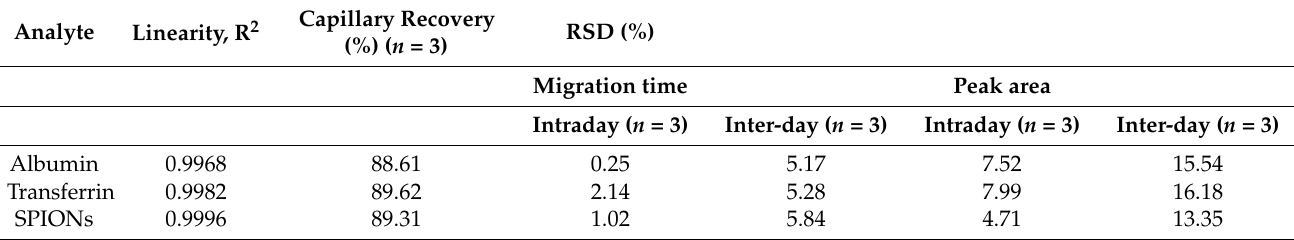
Table 3. Figures of merit of the optimized CE-ICP-MS/MS method.